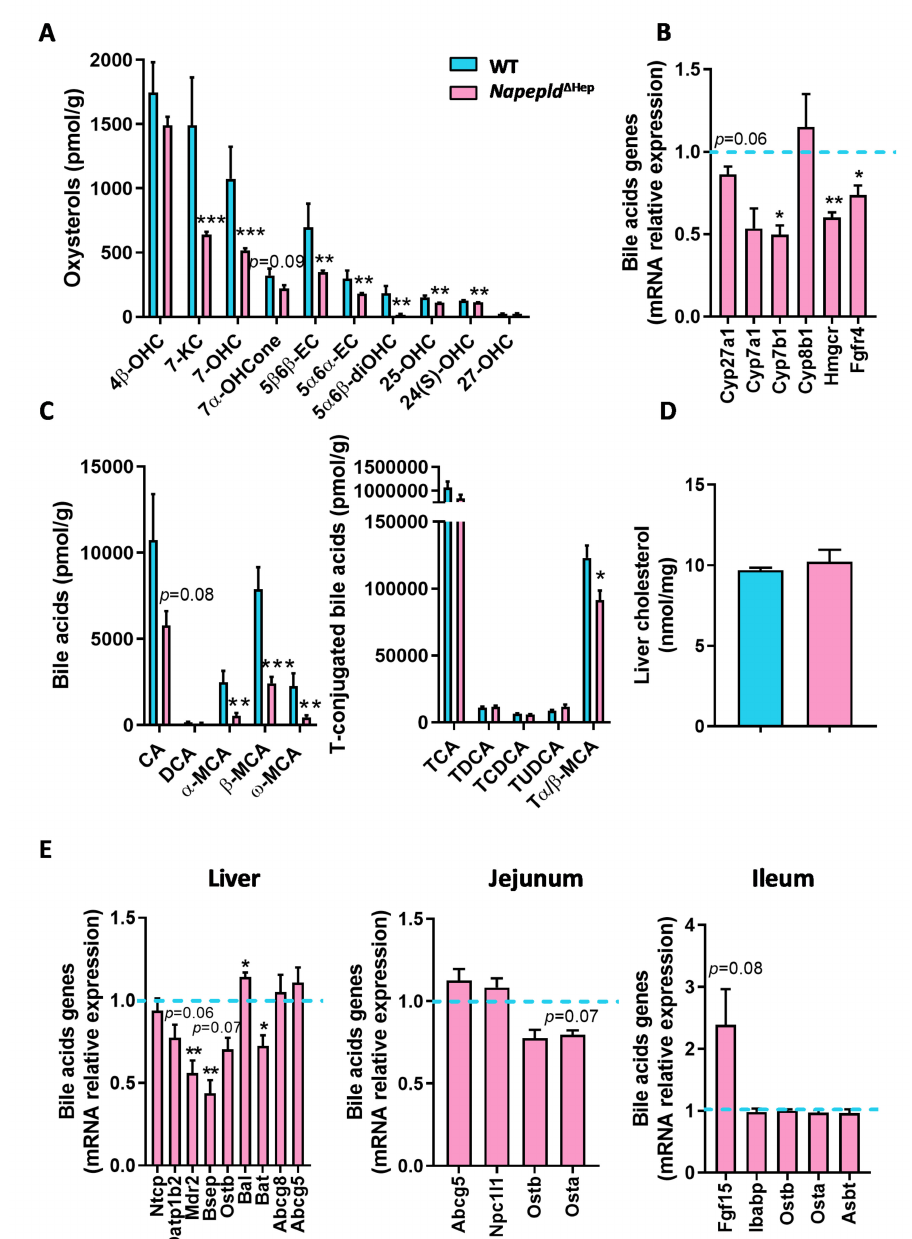
Figure 4. Hepatocyte Napepld deletion modifies liver bioactive lipid metabolism. ( A ) Liver oxysterol concentration (pmol / g). ( B ) Key markers of bile acid metabolism measured by real-time qPCR in the liver. ( C ) Liver bile acid concentration (pmol / g). ( D ) Liver cholesterol concentration (nmol / mg). ( E ) Markers of the enterohepatic feedback loop involved in bile acid metabolism measured by real-time qPCR in the liver, jejunum and ileum. Blue: WT ND mice. Pink: Napepld ∆ Hep ND mice ( n = 8–10). Data are presented as the mean ± s.e.m. *, ** and *** indicate a significant di ff erence versus WT ND (Respectively p < 0.05, p < 0.01 and p < 0.001) according to the t -test. Lipid abbreviations: 24(S)-OHC, 24(S)-hydroxycholesterol; 25-OHC, 25-hydroxycholesterol; 27-OHC, 27-hydroxycholesterol; 4 β -OHC, 4 β -hydroxycholesterol; 5 α 6 α -EC, 5 α ,6 α -epoxycholesterol; 5 α 6 β -diOHC, 5 α ,6 β -dihydroxycholesterol; 5 β 6 β -EC, 5 β ,6 β -epoxycholesterol; 7-KC, 7-ketocholesterol; 7-OHC, 7-hydroxycholesterol; 7 α